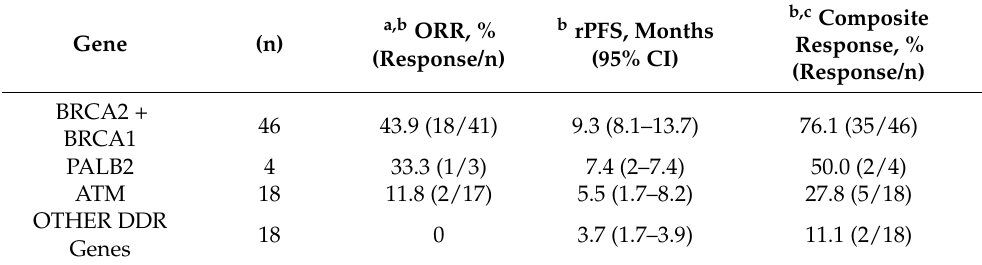
Table 7. TALAPRO-1 Study: Interim